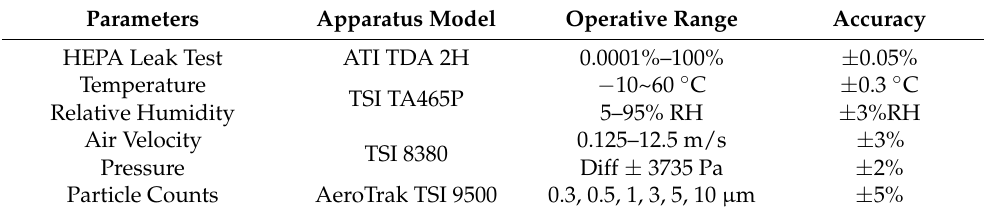
Table 1. Apparatus for field